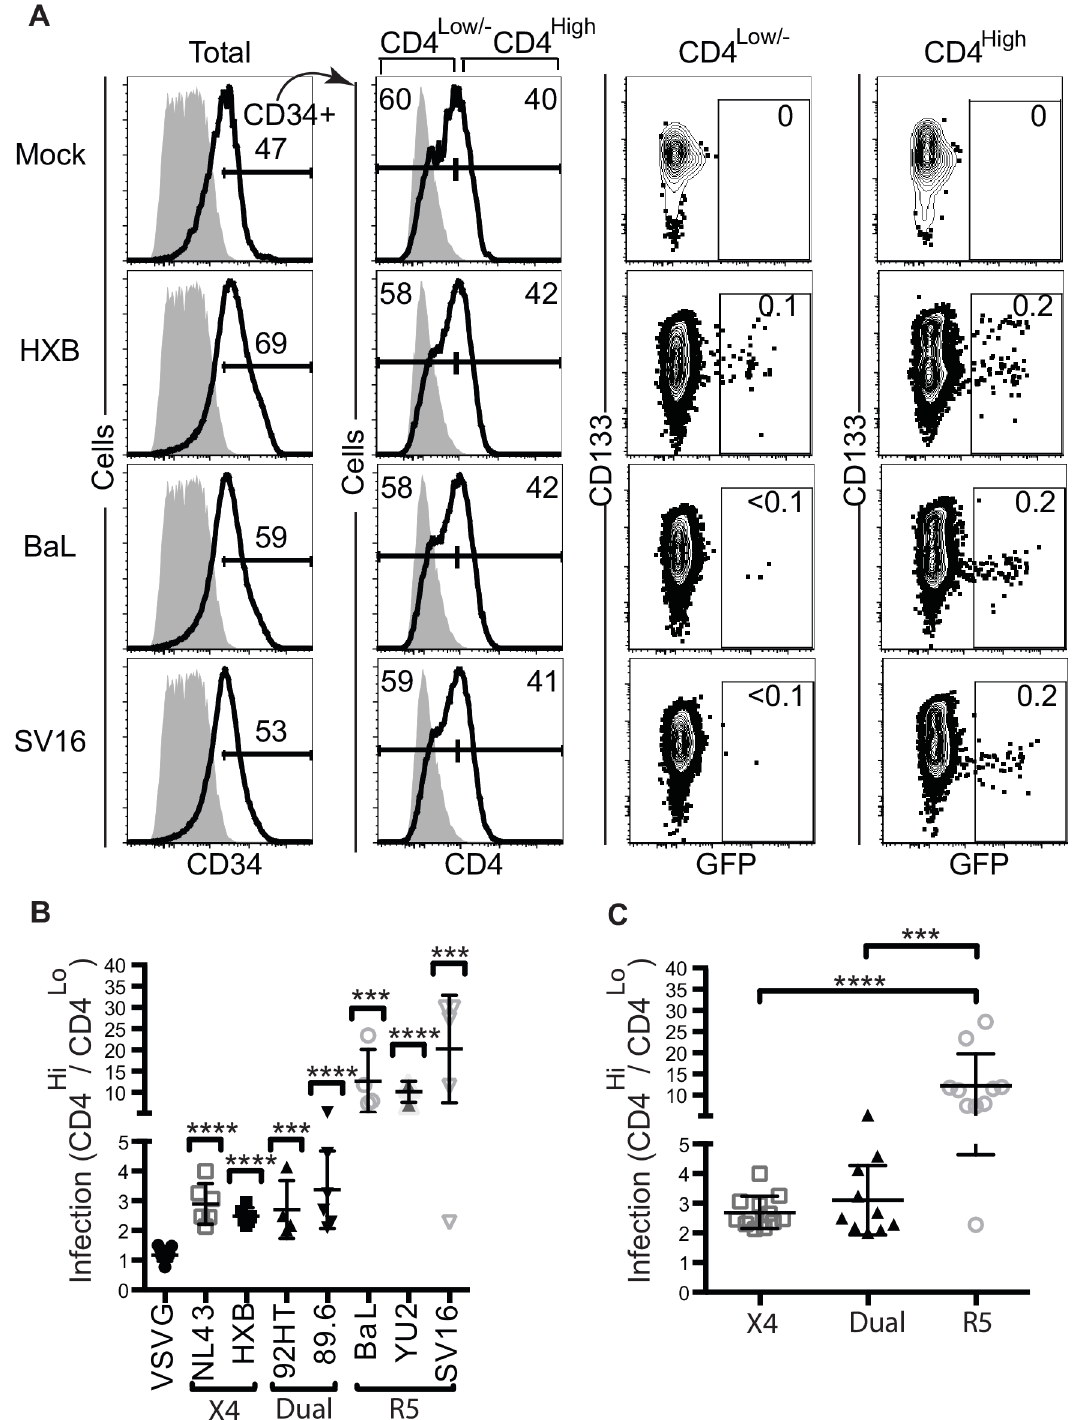
Fig 6. HSPCs with greater CD4 expression are preferentially infected by HIV Envs. A. Representative flow cytometry plots and gating strategy for cord blood-derived CD133-sortedcells infected with virus containingthe indicatedenvelope protein and harvested3 days post-infection. Gating for CD4 was determinedby the inclusionof 1% of cells stained with an isotype control antibody(gray). For GFP plots, numbers indicatethe percentageof GFP + events. B. Summary graphs depictingthe ratio of infected cells in CD4 high versus CD4 low/- subsets of cord blood-derived HSPCs infected and analyzed as in part A. For SV16, two replicateshad 0.0% infectionin the CD4 low/- gate leadingto an undefinedratio, so 30.0 was used